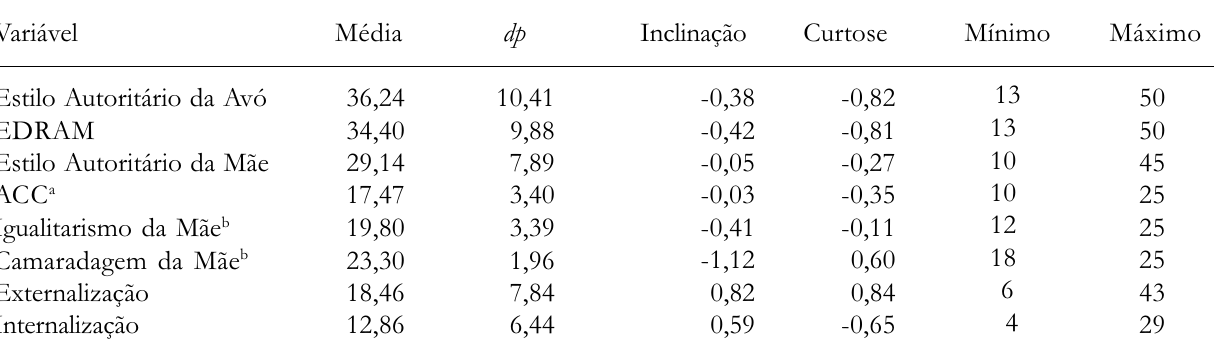
Tabela 1. Estat(cid:237)sticas Descritivas das VariÆveis ( n =50)